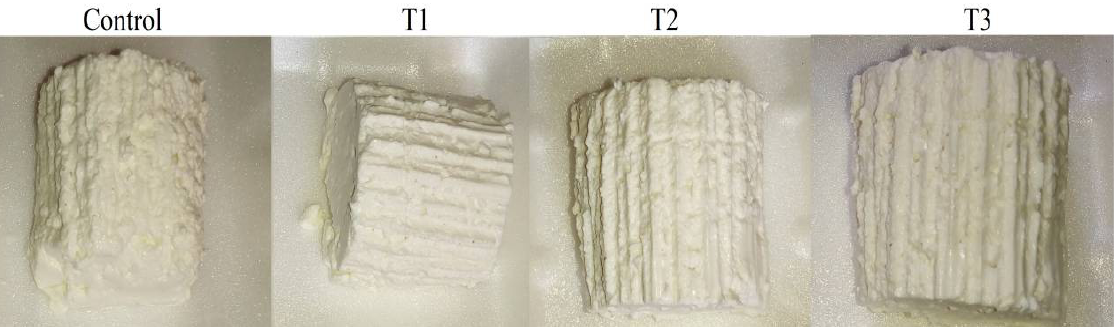
Figure 2. Fortified Karish cheeses: C: Control cheese (normal cheese without treatment) and T1, T2 and T3 are supplemented cheese (laboratory-made Karish cheese fortified by quadr-mix extract of degradants (lemon+ apple + grape+ cell free supernatant of L. acidophilus ); T1 = Mix extract (1 g) (1 g extract quadri-mix/100 g Karish cheese); T2 = Mix extract (1.5 g) (1.5 g extract quadri-mix/100 g Karish cheese); T3 = Mix extract (2 g) (2 g extract quadri-mix/100 g Karish cheese)) .